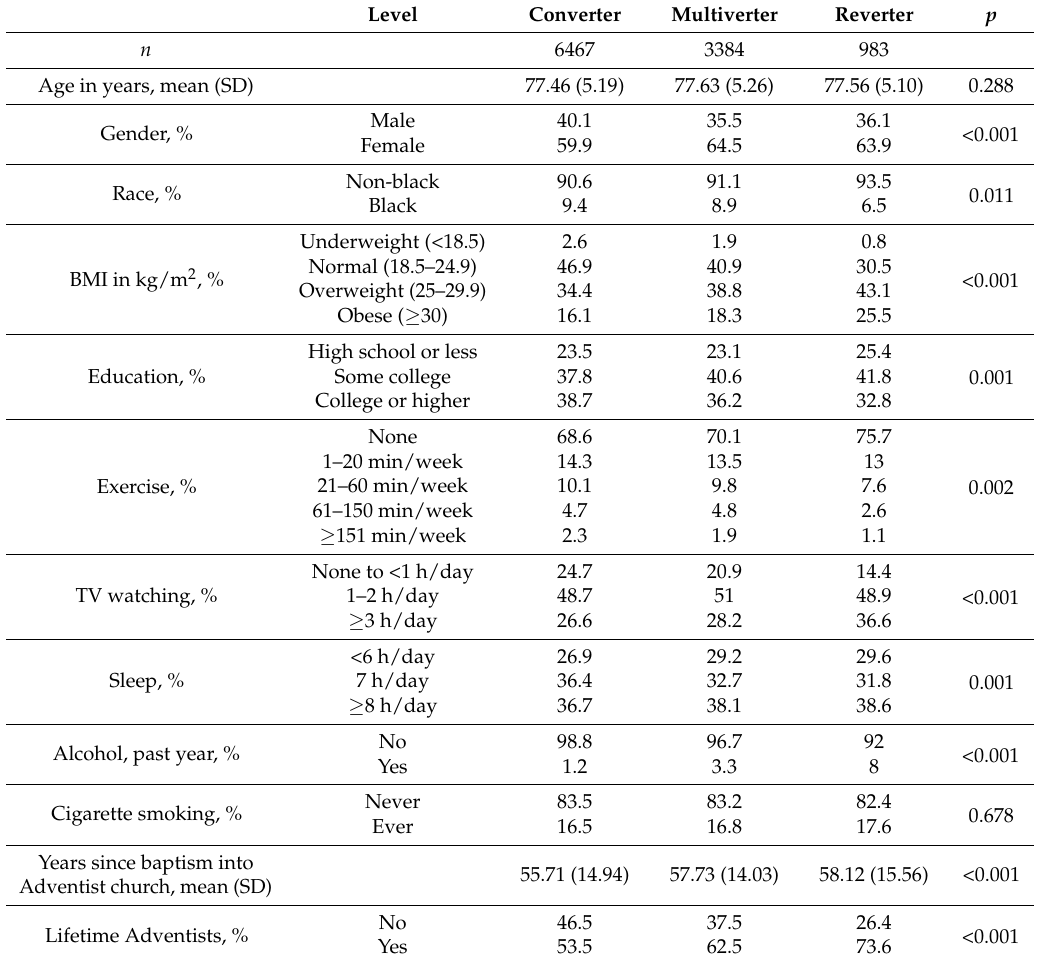
Table 2. Distribution of non-dietary variables among Adventists aged 70+ years who were switchers (converters, multiverters, reverters) between dietary patterns